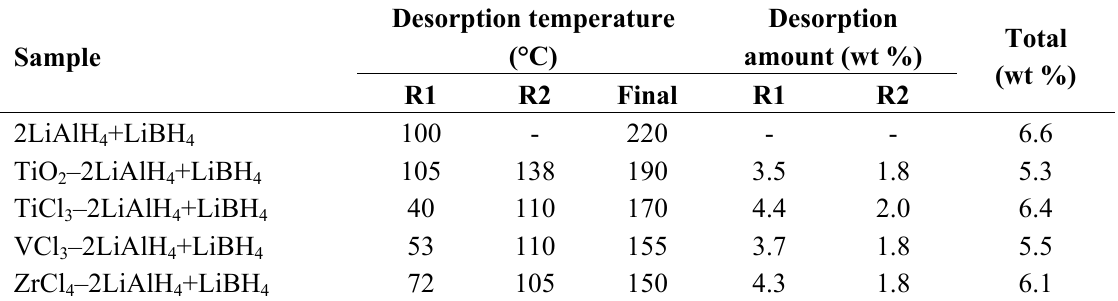
Table 2. Hydrogen desorption temperature and amounts of desorbed hydrogen of +LiBH mixed with 1 mol % TiO 2LiAlH 4 4 second (R2)